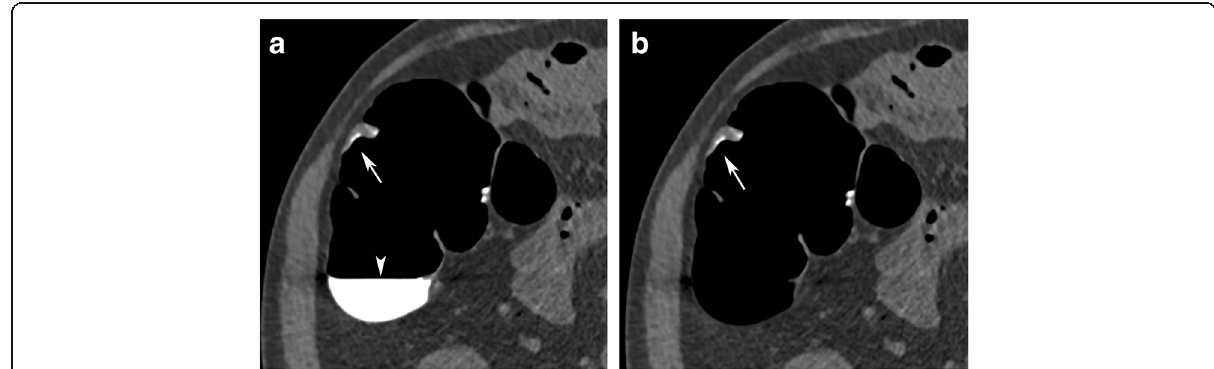
Fig. 4 Persistent tagged residue on a flat lesion in the ascending colon. a On the axial 2D image before EC, the soft tissue plaque-like lesion is coated by a thin layer of hyperdense tagged residue (arrow). Tagged residual fluid is seen on the dependent colonic wall (arrowhead). b After EC, the layer of contrast media remains on the flat lesion (arrow) while the residual fluid was removed. Note that “ contrast coating ” of polyps has been reported to aid in polyp detection. Focal deposits of contrast media are therefore intentionally not removed by